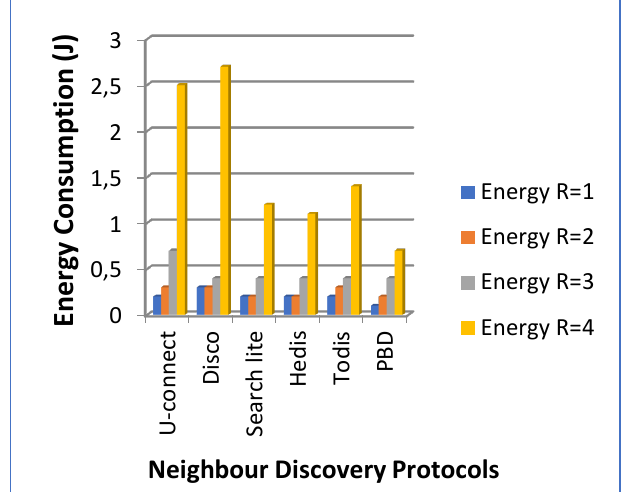
Figure 5. Comparison among different